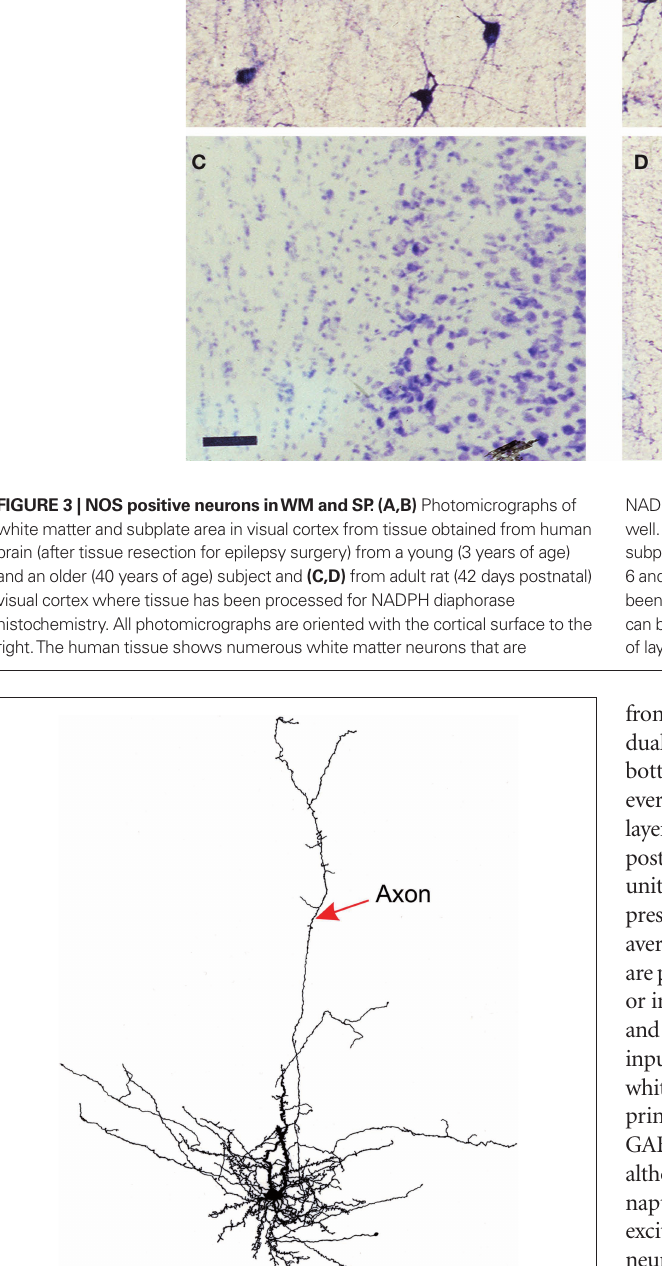
FIGURE 4 | Line drawing of a rat subplate neuron that has been fi lled with biocytin in a brain slice experiment. The cell’s dendrites cluster around the soma at the base of layer 6 but its axon extends vertically into the cortical